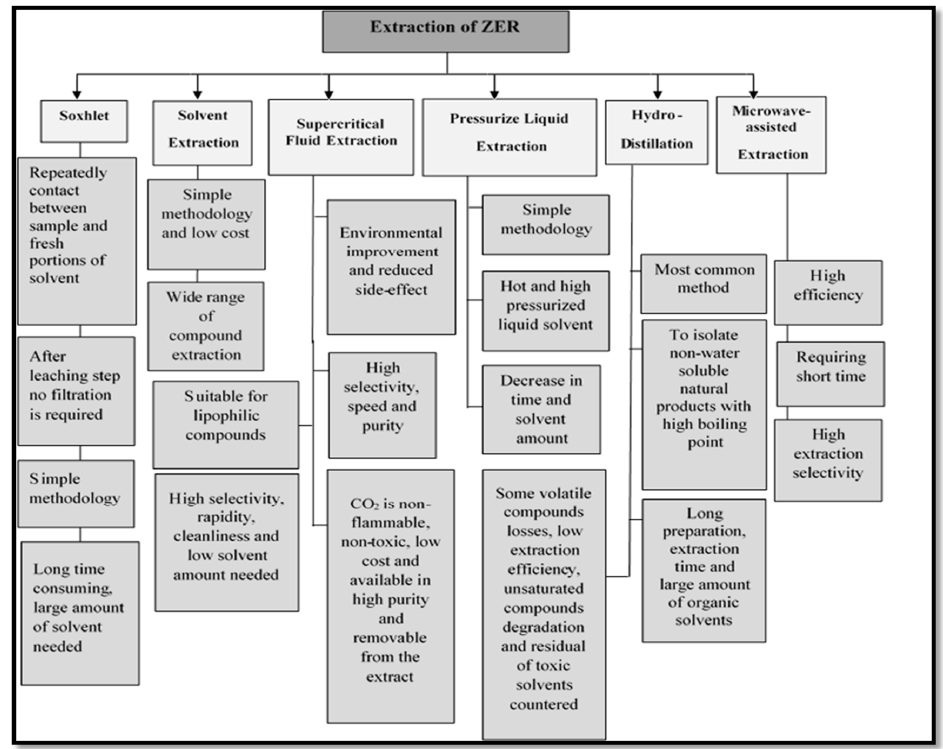
Figure 2. Different methods of ZER extraction.